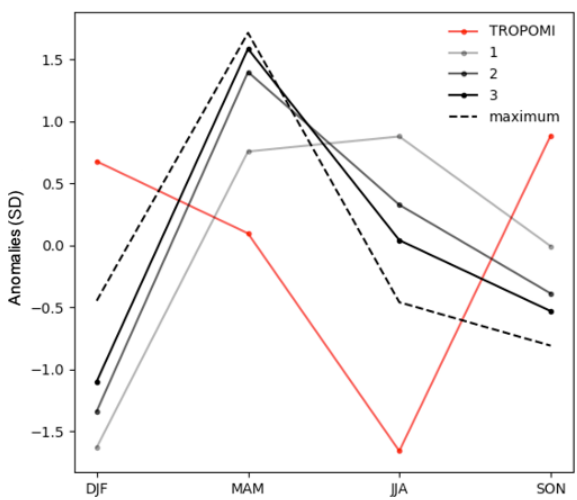
Figure 6. Seasonal cycle of SSWR emissions. Methane emis- sions from the Wetcharts full ensemble for 2010 (December 2009– November 2010) and TROPOMI are shown. The solid lines show the average of an emission estimate ensemble for a temperature de- pendency ( q 10 ). The dashed line shows the seasonal cycle of the Wetcharts estimate that has the largest annual emissions. All values are shown in units of standard deviation.